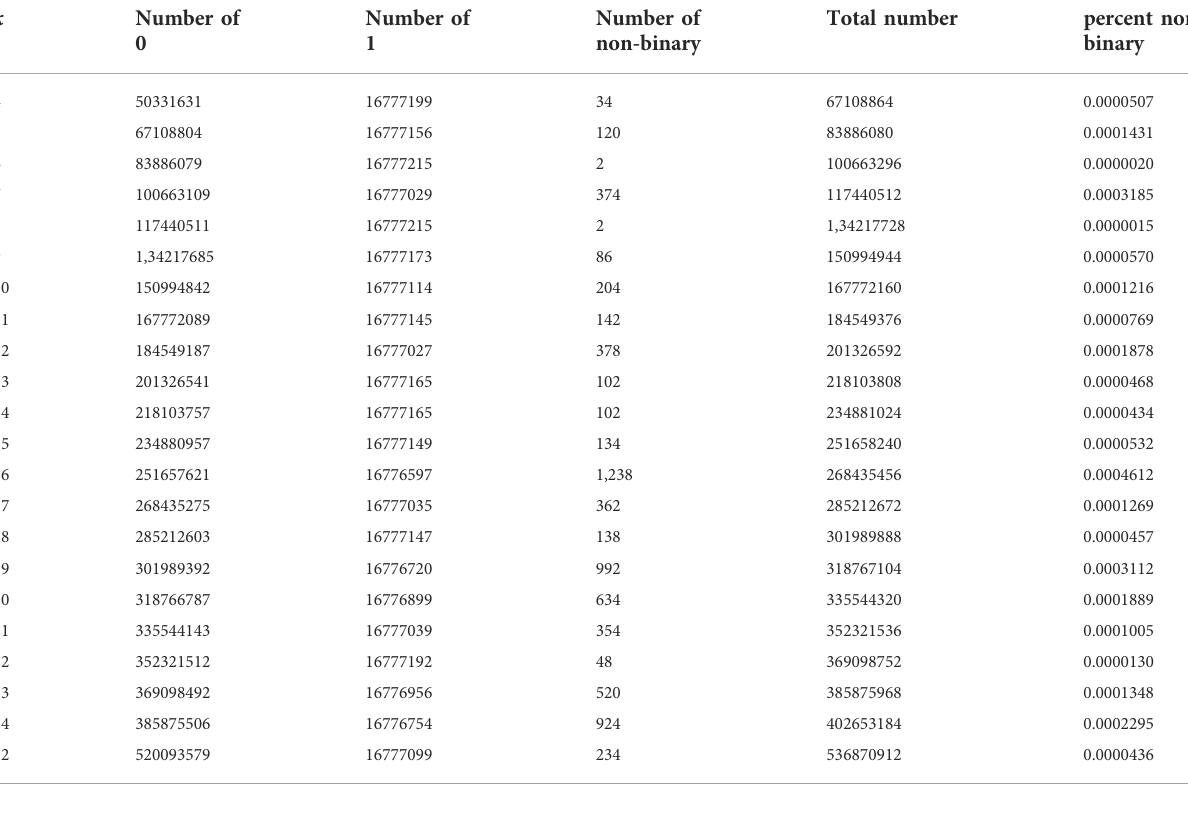
TABLE 2 Description of the values in the binary masks (0, 1 or non-binary values) which were obtained by the k-textures model for all the k classes presented in this work (from 2 to 24 and 32).